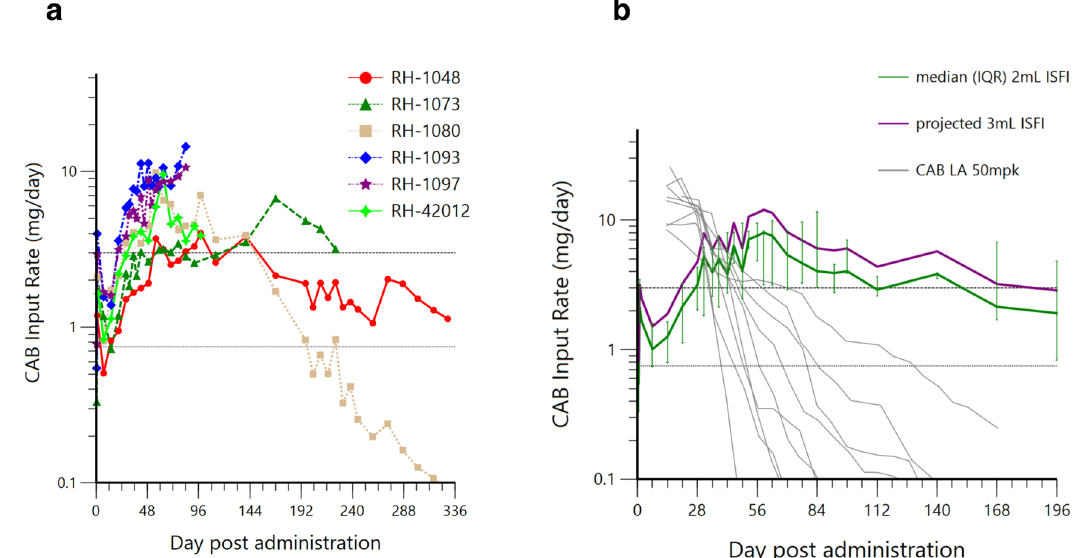
Fig. 8 | CAB input rate (mg/day) from macaque studies and modeling for clin- icaltranslation.a CABISFIinputrateisestimatedbymultiplyingobservedplasma concentrations with each respective animals ’ clearance as determined by their extravascularPKpro fi le.Dashed and dotted referencelines denote input rates of 3 and 0.75mg/day which are predicted to achieve plasma concentrations in humans above the 4× PA-IC 90 and PA-IC 90 , respectively. b Median (±IQR) CAB ISFI input